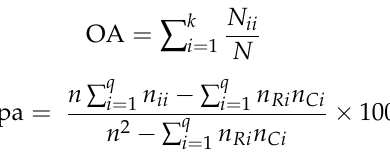
Figure 7. The decision tree approach is based on series of decisions that are used to determine the correct class for each pixel. The chart shows the binary decisions implemented in this study.